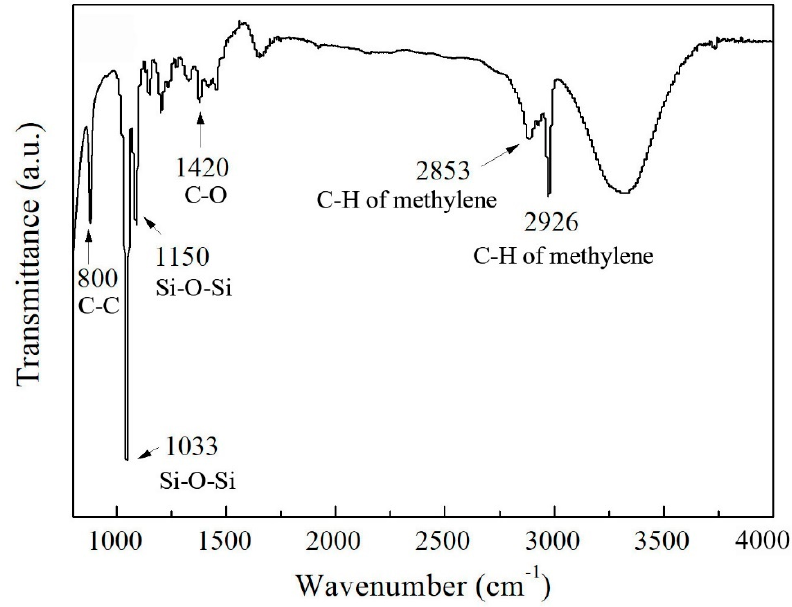
Figure 5. XRD patterns of the TiO 2 nanoparticles, the AAO, and the fabricated PFDS/TiO 2 @AAO surface.